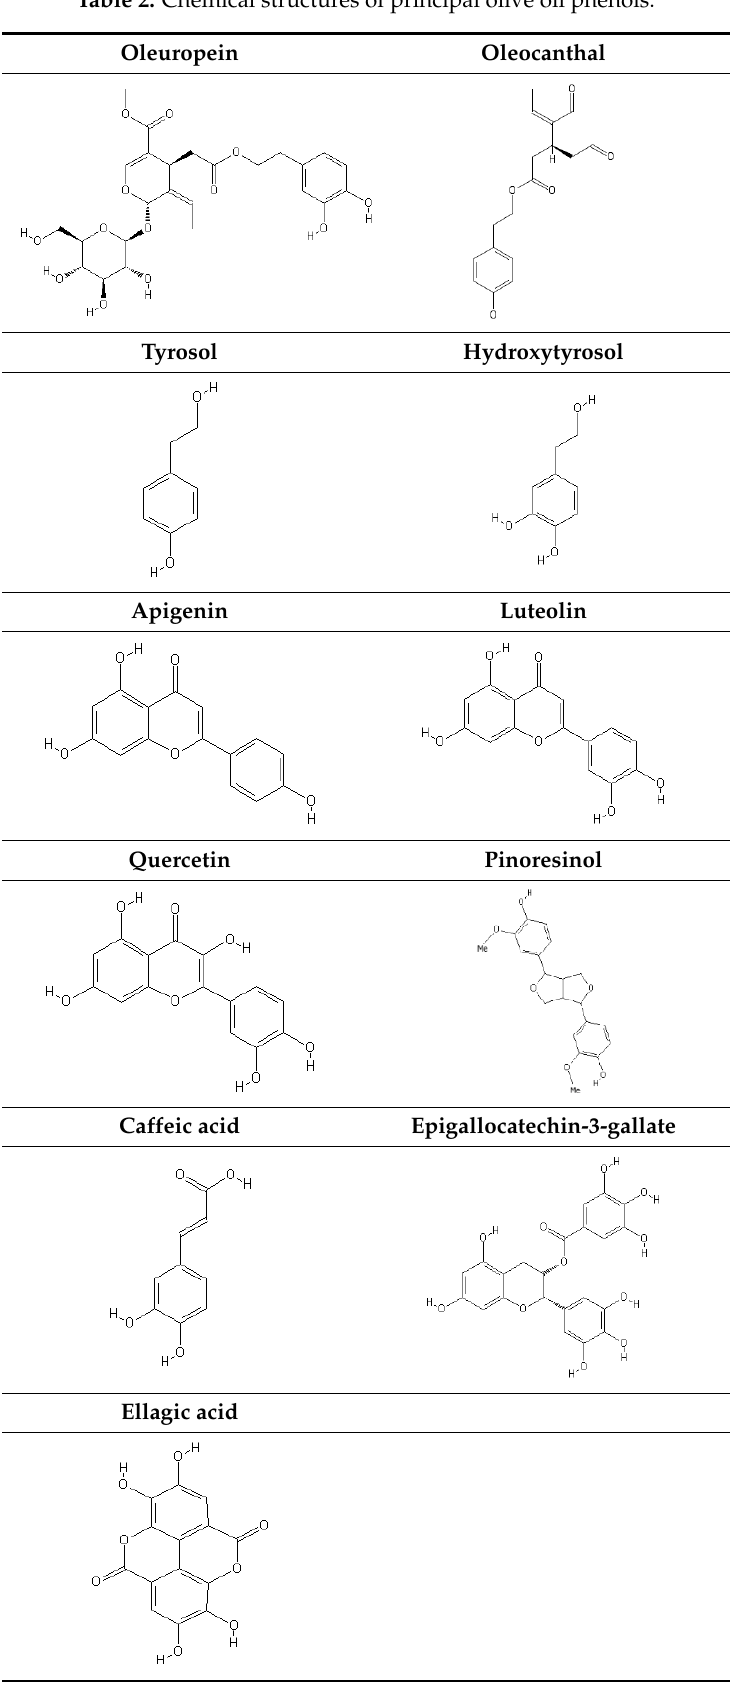
Table 2. Chemical structures of principal olive oil phenols.